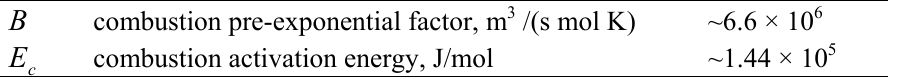
Table 8. Kinetic data for global combustion reaction of PMMA.